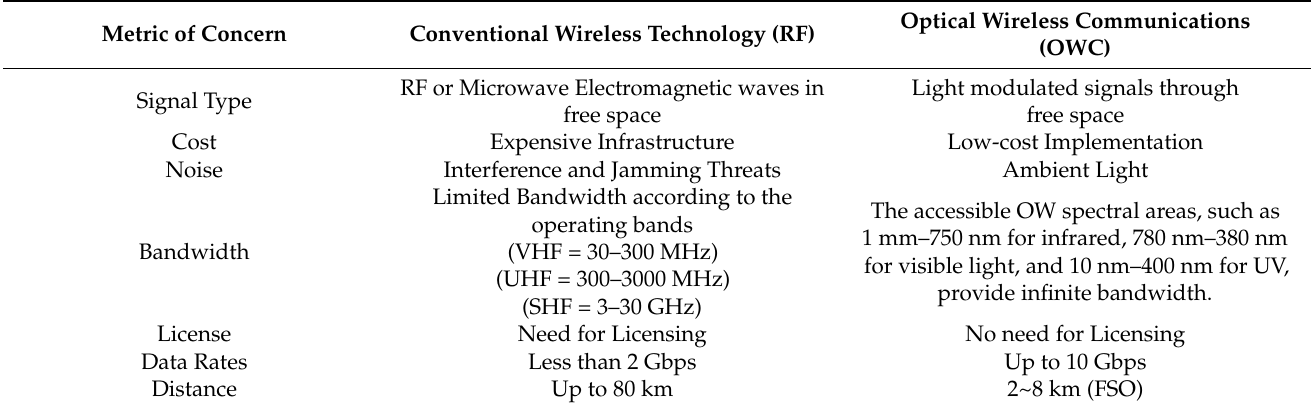
Table 1. RF vs. OWC technologies